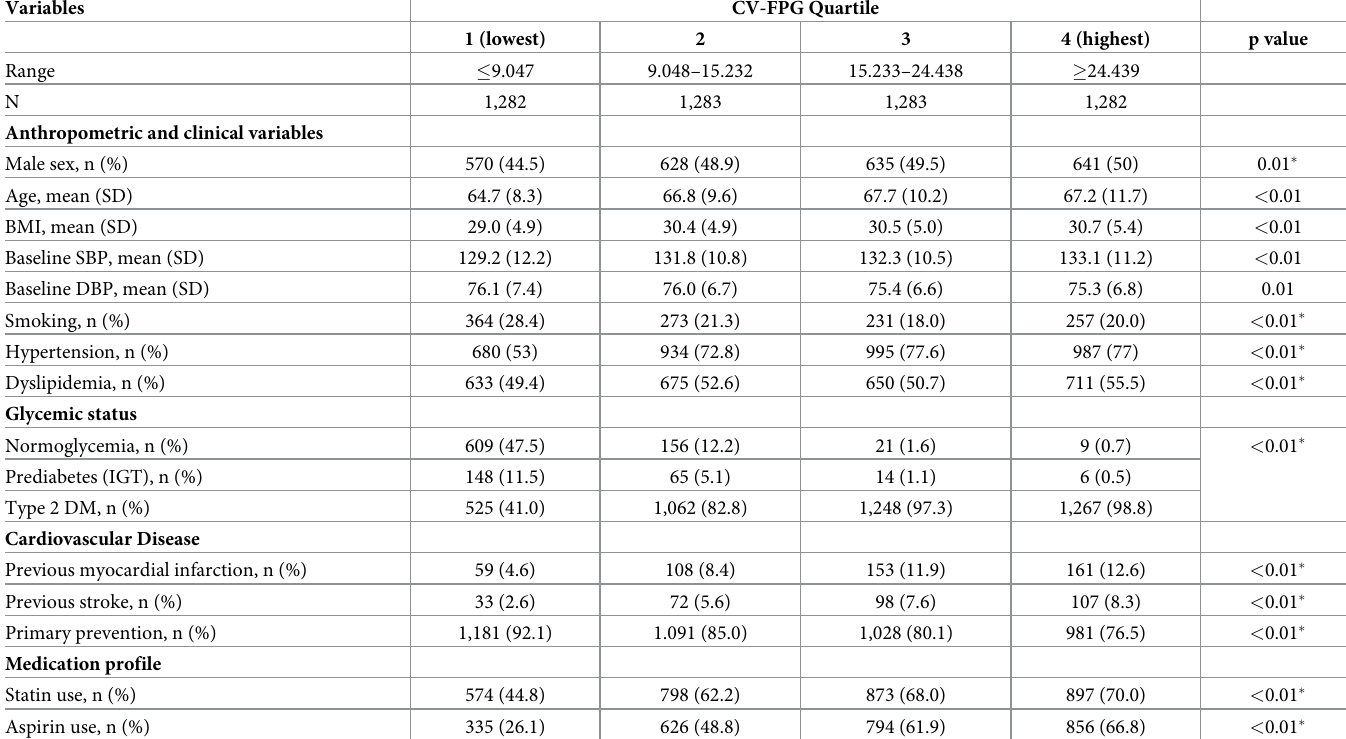
Table 3. Baseline factors of 5,130 subjects with differences in glycemic status grouped by CV-FPG quartile.